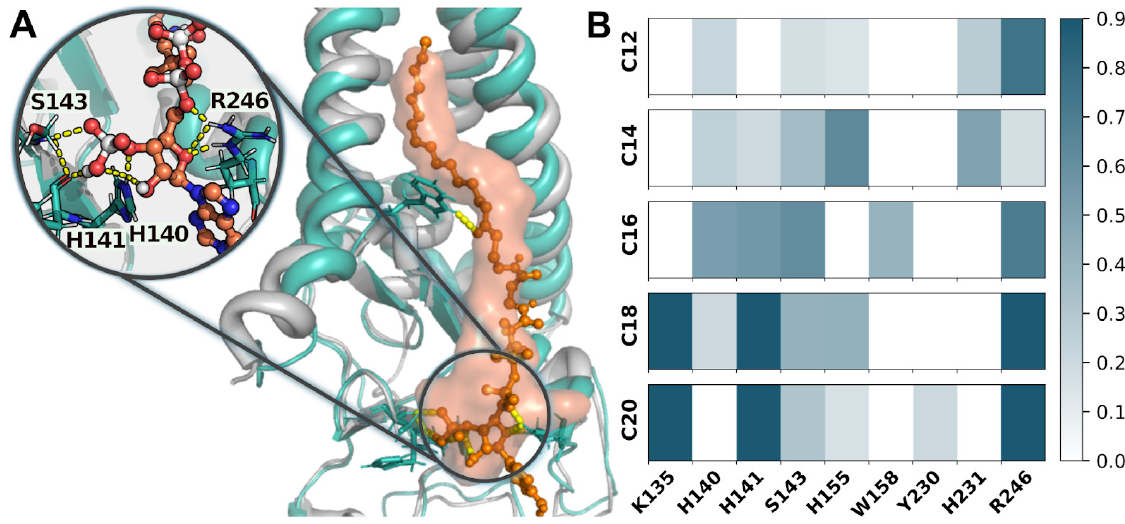
Figure 3. Key polar contacts of the acyl-CoA head with hDHHC20 during MD. ( A ). Comparison of the hDHHC20/C16-CoA complex from MD (hDHHC20— green ; C16-CoA— orange balls & sticks ) with the starting crystal structure (hDHHS20— gray ; C16-CoA—s emi-transparent orange surface ). Amino acid residues that bind acyl-CoA by h-bonds ( yellow dashes ) in MD structure, are shown with sticks . Inset shows the zoomed-in picture. ( B ). H-bonding map between hDHHC20 and acyl-CoA (representative trajectories are shown according to Table 1). Amino acid residues that form h-bonds with >10% lifetime in at least one trajectory are shown and colored according to the scale.